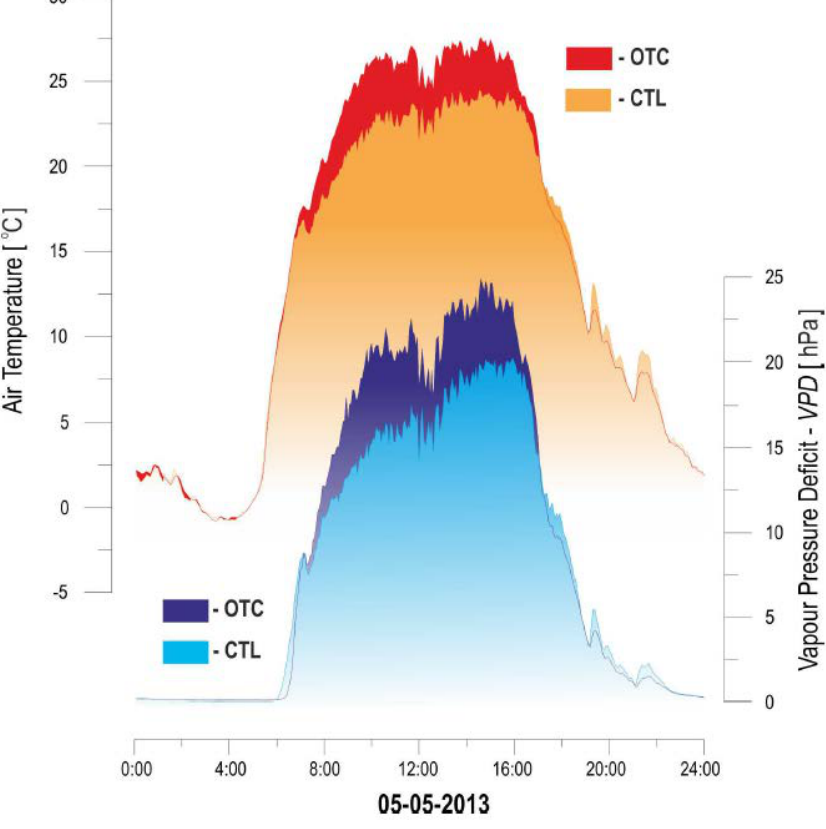
Figure 5. Daily course of averaged air temperature and vapour pressure deficit ( VPD ) 30 cm above the mire surface in OTCs and CTLs plots on 05 May 2013 – exemplary day with the strongest OTC